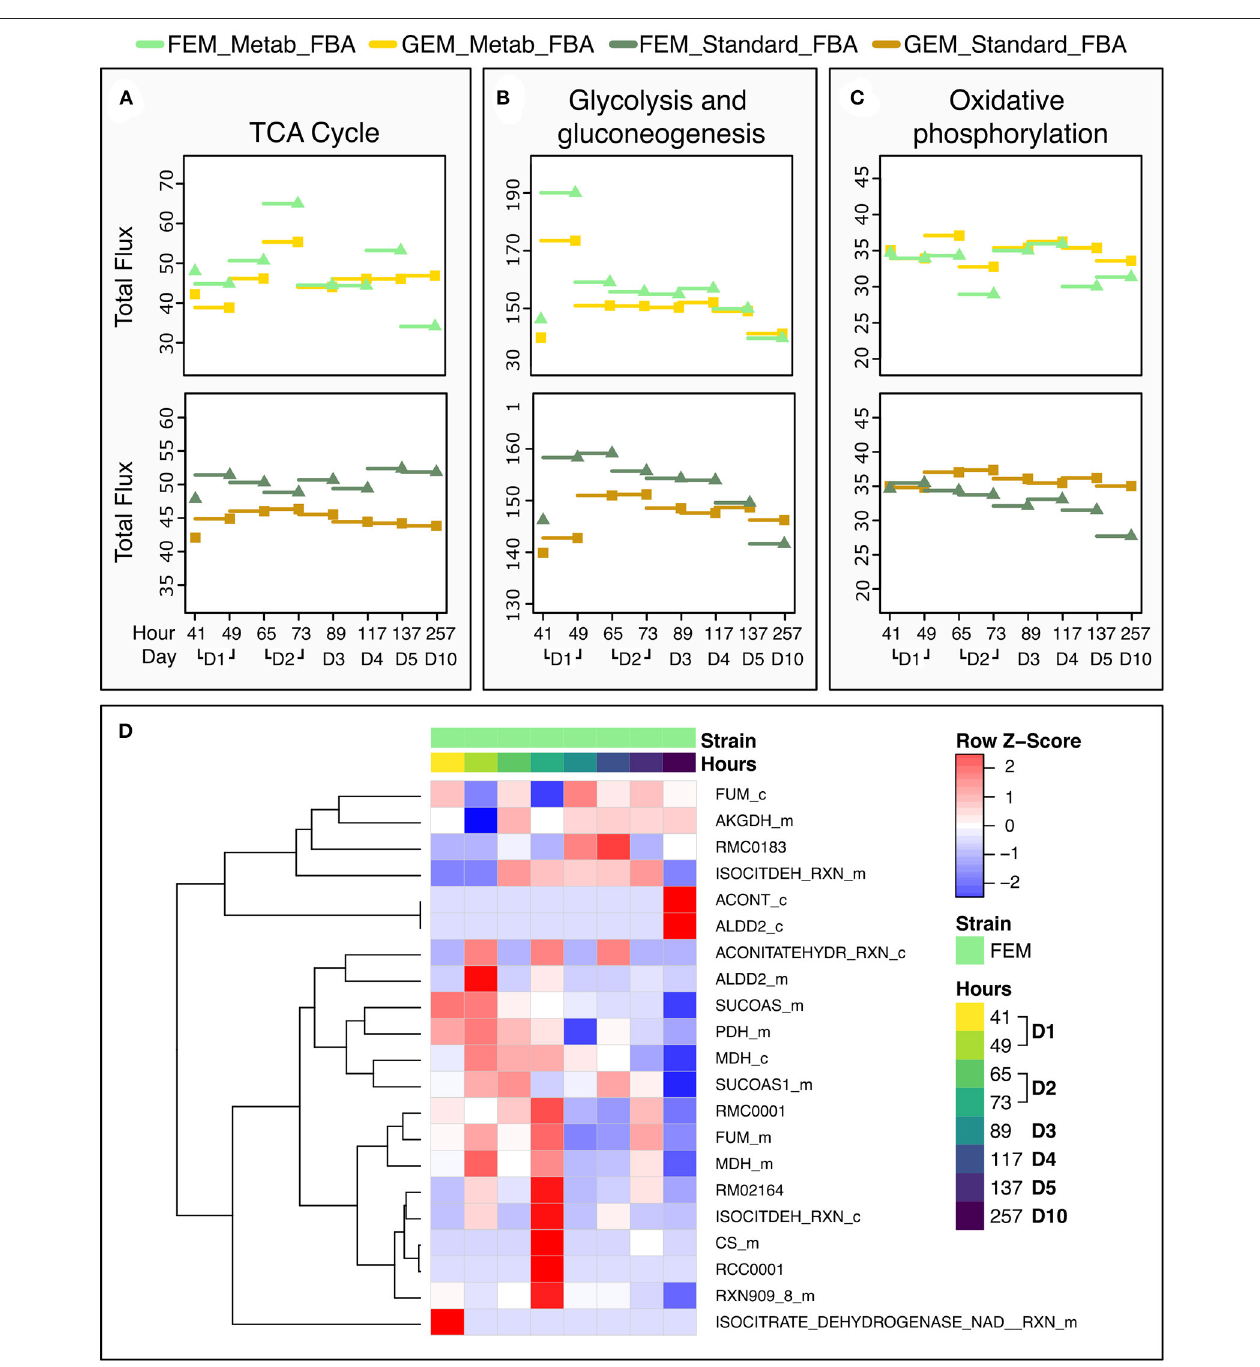
FIGURE 6 | Dynamic changes in pathway fluxes over time. (A–C) Dynamic Changes in Fluxes as a function of age, grouped by pathways. These plots show the magnitude of summed flux values at different timeframes per strain and pathway for the TCA cycle (A) , glycolysis (B) , and oxidative phosphorylation (C) . As before, the fluxes are plotted against the timepoint that provided the transcriptomics data. Example the flux at 137h is the flux computed for the timeframe between 117 and 137h. (D) Heat Map of the Fluxes catalyzed by reactions related to the TCA cycle in FEM animals at day 1 (41 and 49h), day 2 (65 and 72h), day 3 (89h), day 4 (117h), day 5 (137h), and day 10 (257h). Note that time point 97 is not shown as there were no significant metabolic differences at that time point. Greater flux values are indicated in red, lower in blue. As the underlying model represents bidirectional reactions, in some cases, fluxes in the reverse direction are encoded by negative flux values. The heat map here shows the absolute magnitude of the fluxes; the direction of the fluxes and the reactions are given in Supplementary Tables 1 , 7 . All reactions and metabolites used by the WormJam model are provided in Supplementary Tables 12 , 13